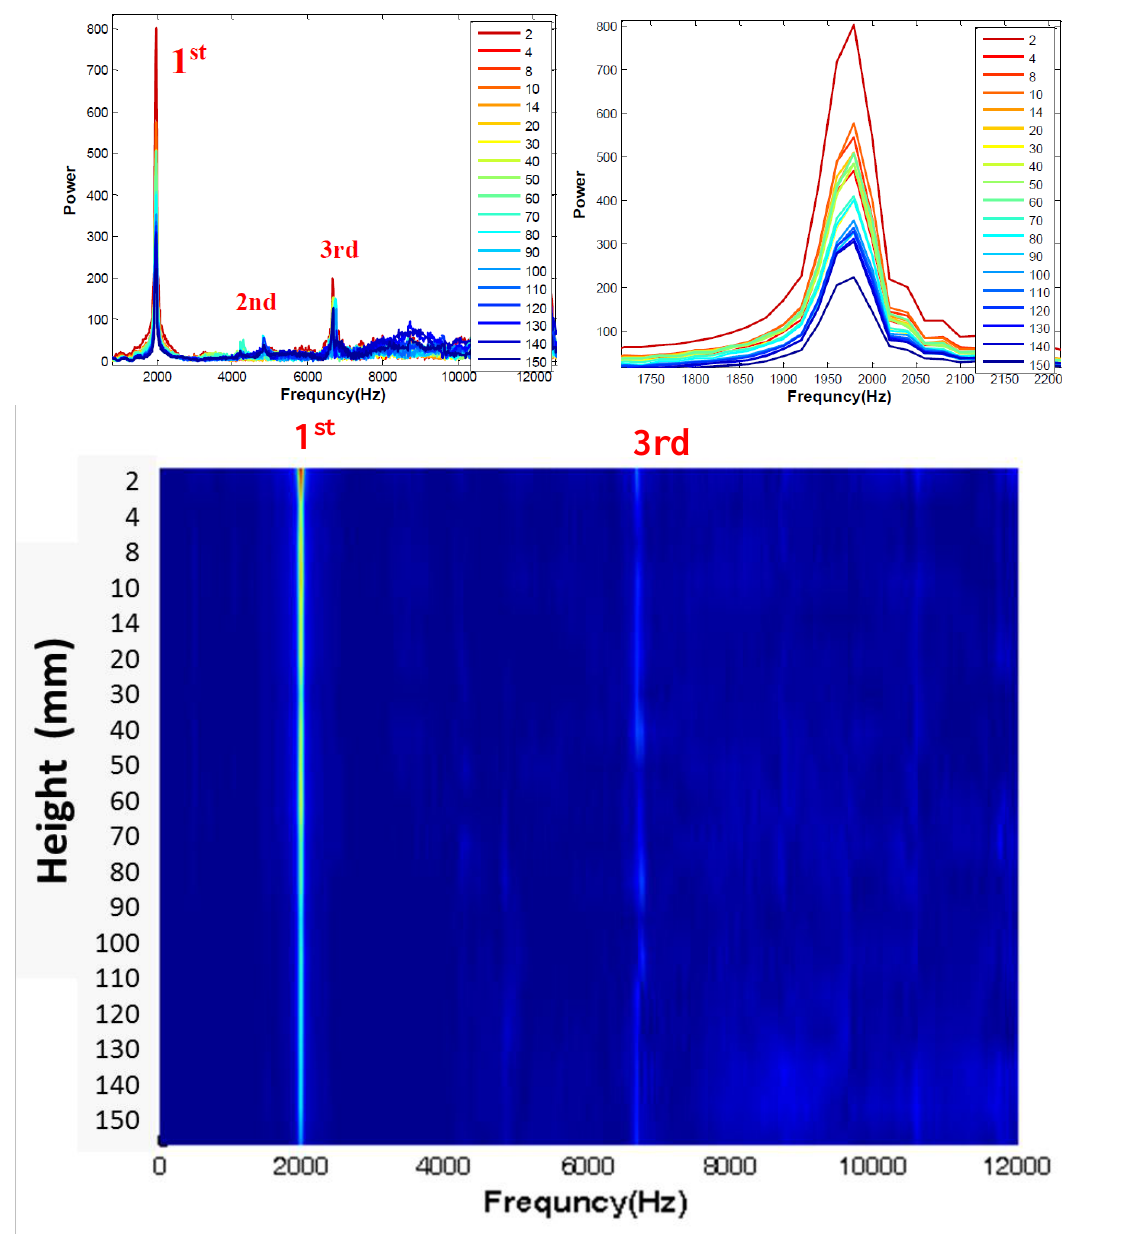
indicate the third mode, likely because of limited frequency bandwidth response and low sensitivity of the DMM and ECM sensors.